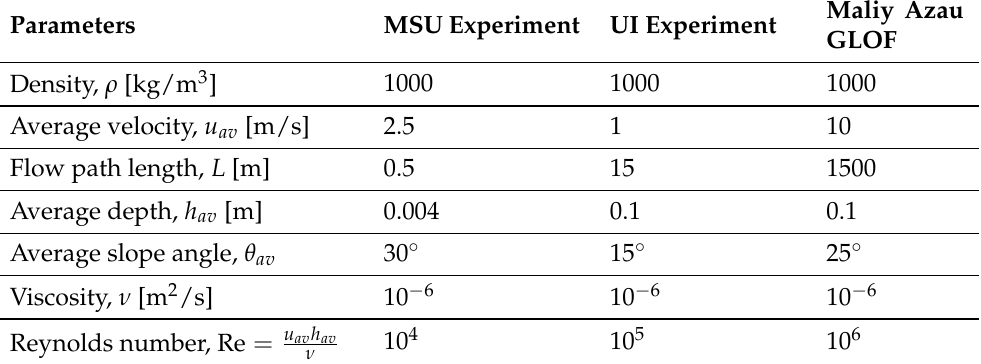
Table 1. Parameters of flows in study.